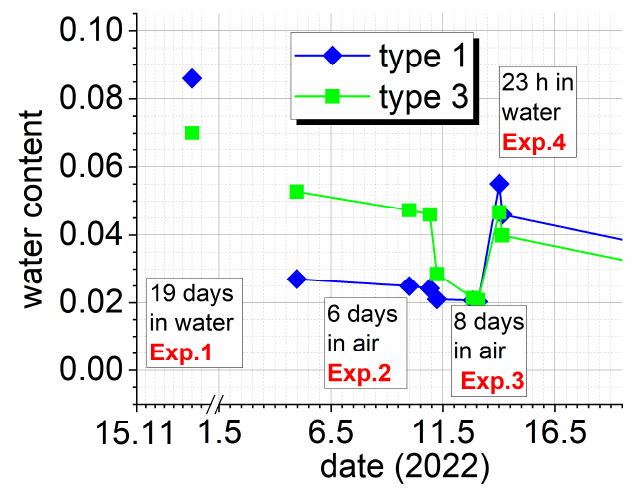
Figure 7. Variation of water content during several soaking/drying cycles. Red font indicates the corresponding photothermal measurements; day data in the boxes refer to type 3. Table 3. Chronology of soaking/drying cycles and the related photothermal investigations .